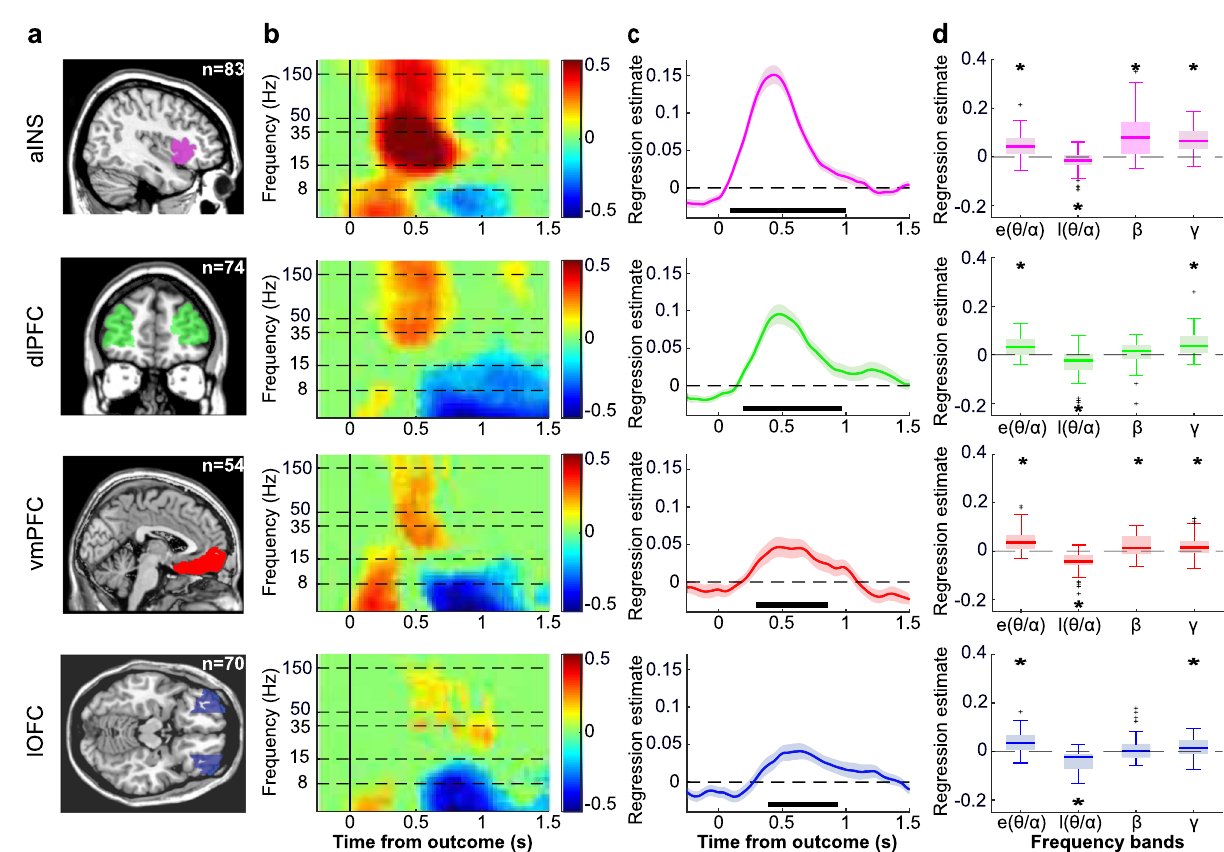
Fig. 3 Investigation of PE signals across frequency bands. a Anatomical localization of the aINS (purple), dlPFC (green), vmPFC (red), and lOFC (blue). All recording sites located in these parcels were included in the ROI analyses. The sample size used to derive statistics in panels b – d are displayed for each ROI (aINS: n = 83; dlPFC: n = 74; vmPFC: n = 54; lOFC: n = 70). b . Time-frequency decomposition of PE signals following outcome onset. Hotter colors indicate more positive regression estimates. Horizontal dashed lines indicate boundaries between frequency bands that are investigated in panels c and d . c Time course of regression estimates obtained from linear fi t of BGA with PE modeled across reward and punishment conditions. Solid lines ( fi lled areas) indicate mean (SEM) across recording sites. Horizontal bold black lines indicate signi fi cant clusters ( p c < 1 × 10 − 3 ; one-sample, two-sided Student ’ s t test after cluster-wise correction). d Regression estimates of power against PE, averaged over early (0 – 0.5 s) and late (0.5 – 1 s) post-stimulus windows for the lower-frequency bands ( θ / α : 4 – 13 Hz) and over the 0.25 – 1 s window for higher frequency bands ( β : 13 – 33 Hz and broadband γ : 50 – 150 Hz). Center lines, box limits, whiskers, and crosses of the box plots, respectively represent median, interquartile range, and outliers of the data distribution from the n recording sites. Stars indicate signi fi cance (all p values < 0.05) of regression estimates (one-sample, two-sided Student ’ s t test). Error bars correspond to inter-sites SEM and dots correspond to individual recording